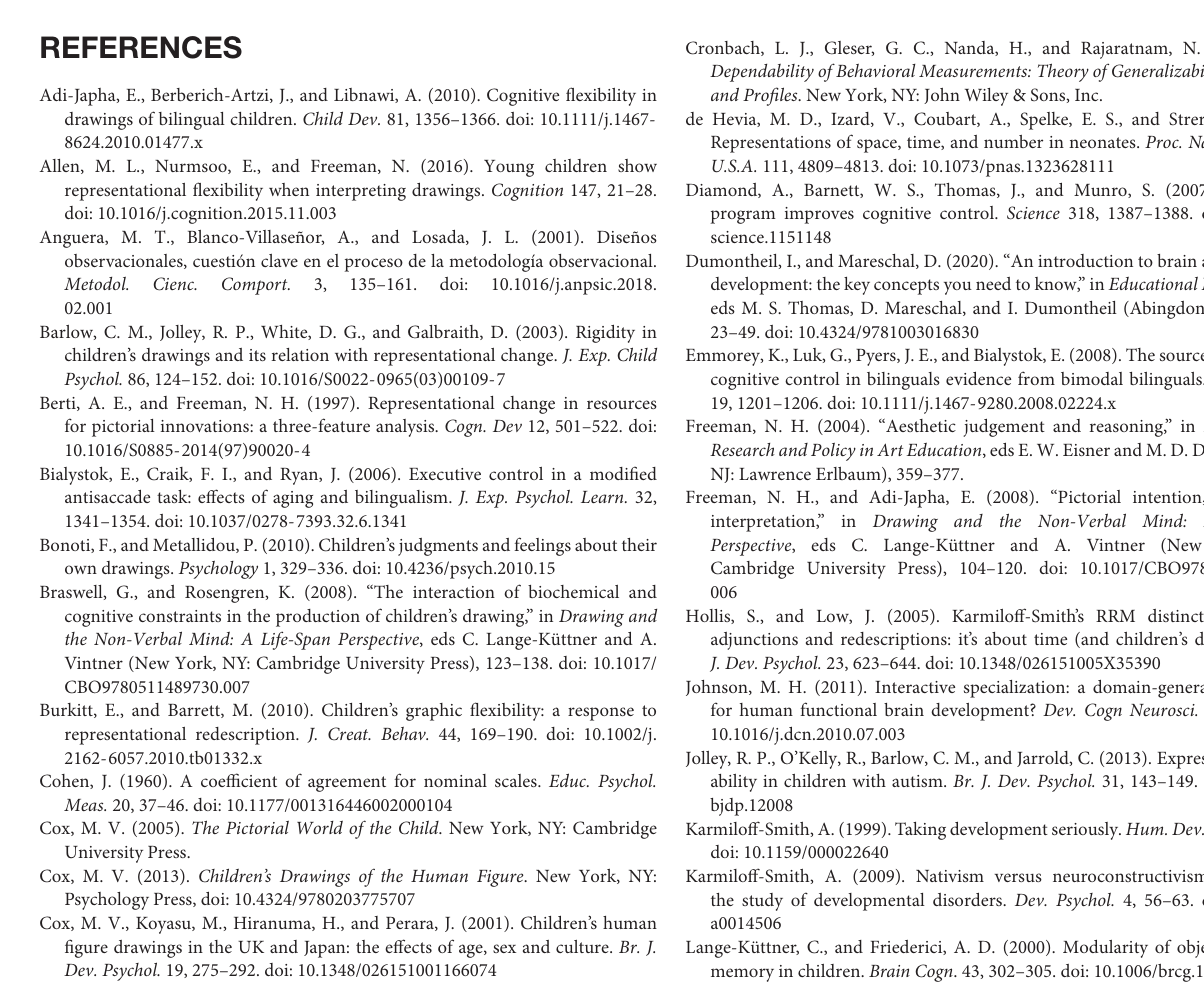
figure drawings in the UK and Japan: the effects of age, sex and culture. Br. J. Dev. Psychol. 19, 275–292. doi: